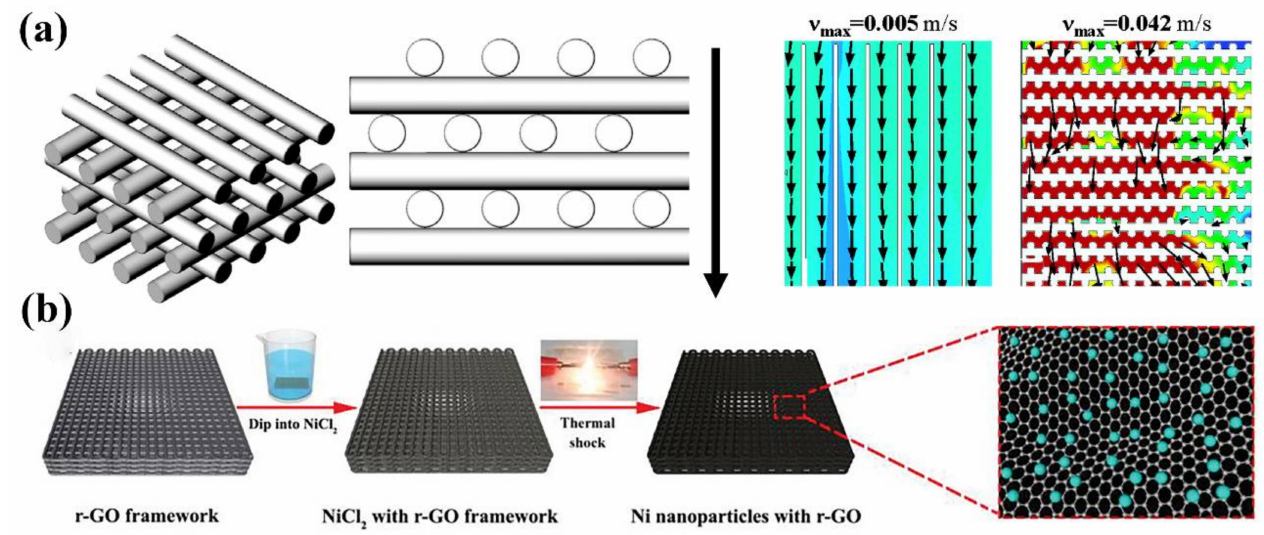
Figure 3. ( a ) Schematic of FCC structure (left) and simulation of velocities (right); [53]. Reproduced with permission from ref. (Stuecker al., 2004) Copyright, 2004, ACS. ( b ) The synthesis process of 3D-printed r-GO framework anchored with Ni nanoparticles [55]. Reproduced with permission from ref. (Qiao et al., 2018) Copyright, 2018, John Wiley and Sons.